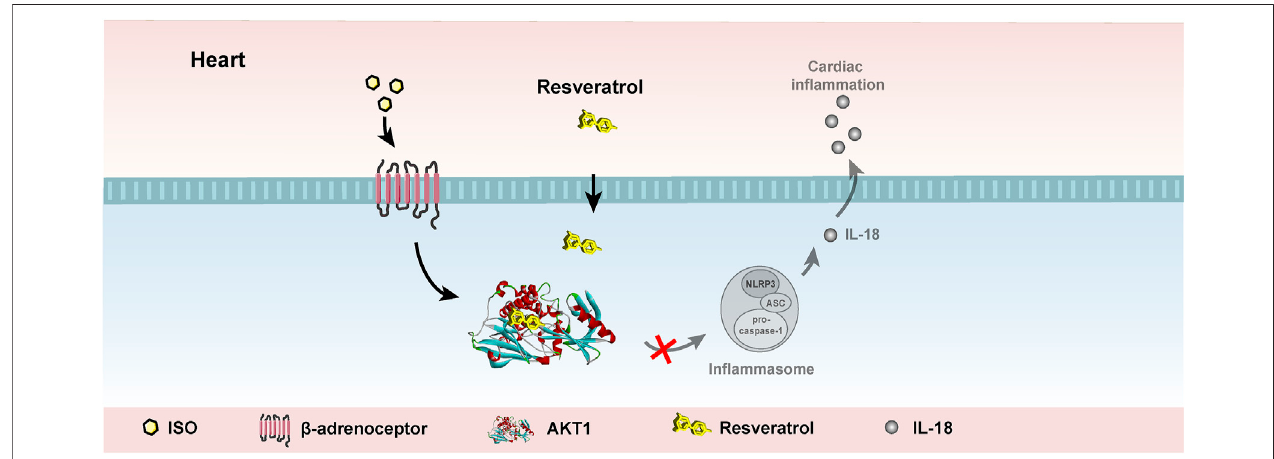
FIGURE 7 | Working model. Resveratrol suppresses acute sympathetic stress-induced in fl ammasome activation in cardiomyocytes via inhibiting